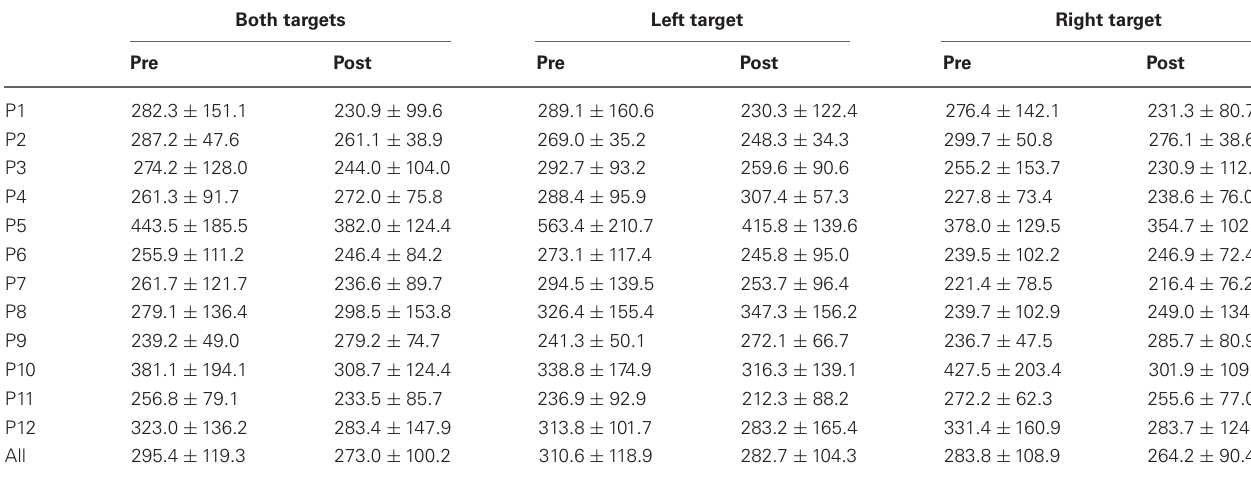
Table 1 | Mean ± Standard deviation of latency in milliseconds for both, left, and right targets in the two periods, for every participant and the group of participants (All).